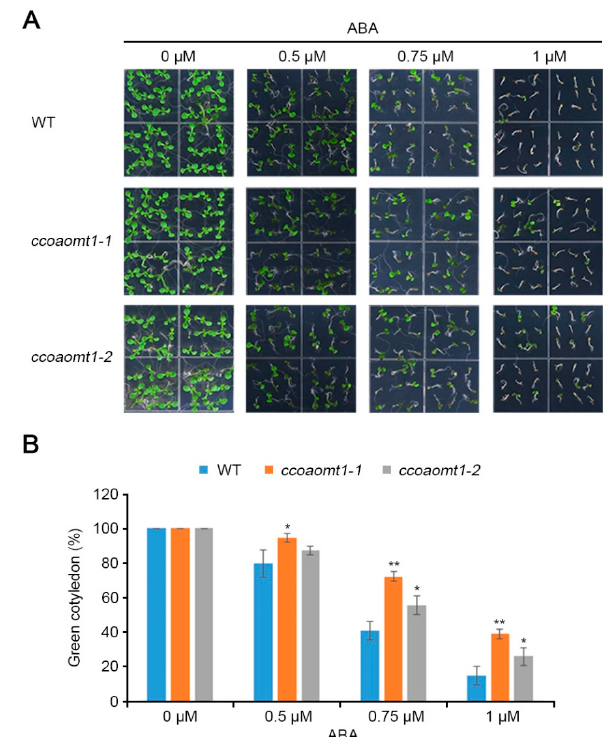
Figure 6. ABA-responsive phenotype of ccoaomt1 mutants during seed germination in the presence of ABA. ( A ) Morphological phenotype of WT and ccoaomt1 mutants ( ccoaomt1-1 and ccoaomt1-2 ). Seeds were germinated on an MS medium without (0 µM ABA) or with 0.5 µM, 0.75 µM, and 1 µM ABA, respectively. ( B ) Quantitative value of green cotyledons (%) of WT and ccoaomt1 mutants. Opened green cotyledons were counted from indicated concentrations of ABA (0, 0.5, 0.75, and 1.0 µM) at 5 days after treatment. The values indicated means ± SD of 36 seeds from three independent experiments. Asterisks represent significant differences from the WT (*, p < 0.05; **, p < 0.01; Student’s t -test).